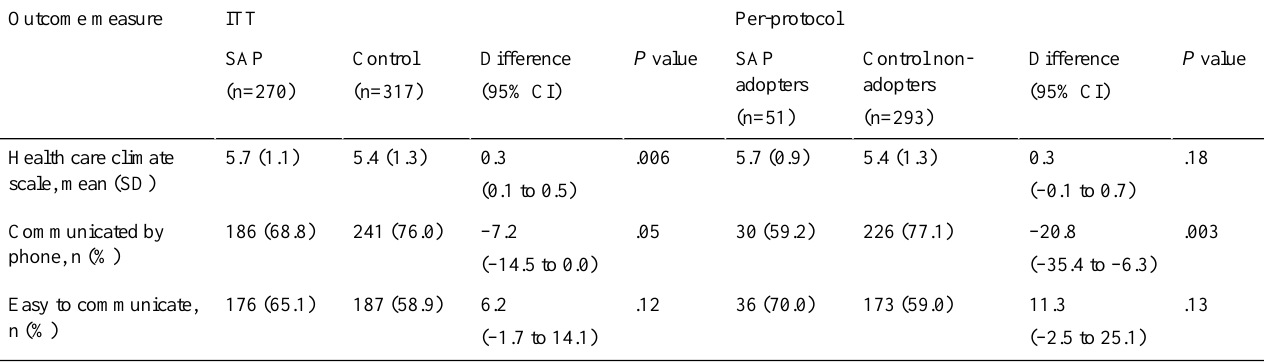
Table 2. Impact of the Supported Adoption Program (SAP) and secure message adoption: intention-to-treat (ITT) and per-protocol analyses. Per-protocolITTOutcome